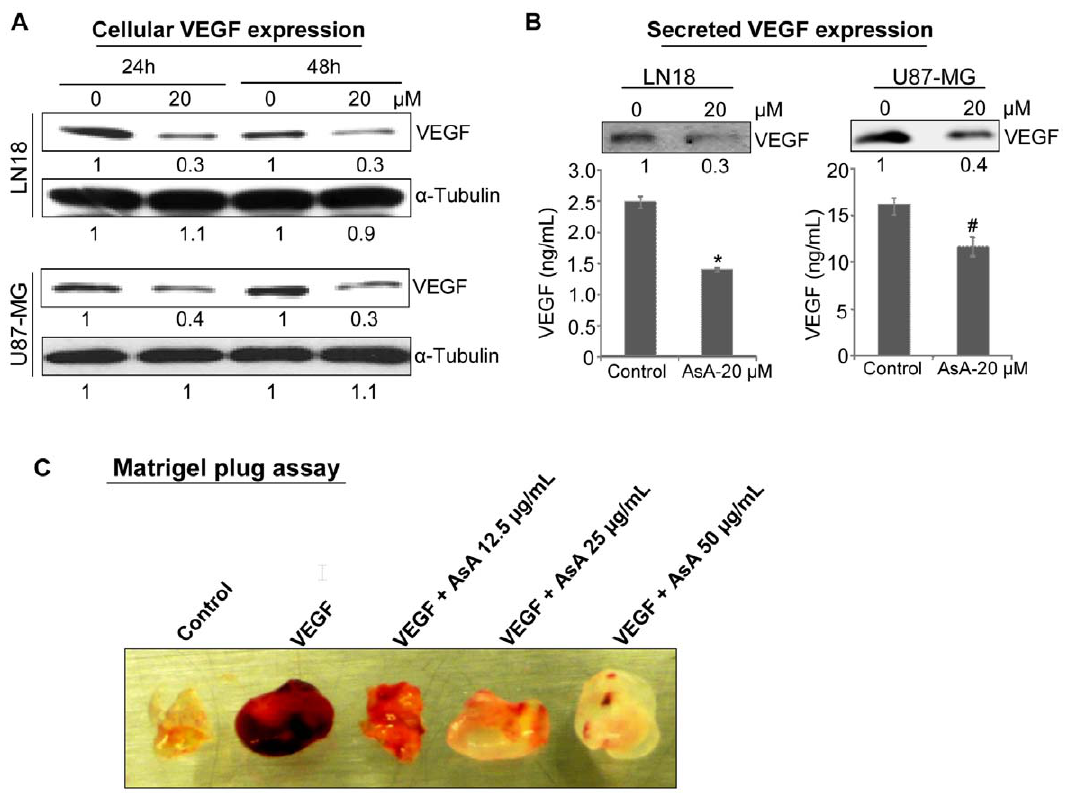
Figure 7. AsA reduces VEGF level (both cellular and secreted) in glioma cells and strongly inhibits VEGF-stimulated angiogenesis in vivo. A. LN18 and U87-MG cells were treated with DMSO or AsA (20 m M) for 24 and 48 h. After each treatment time, cell lysates were prepared and analyzed for VEGF by Western blotting as described in ‘Materials and Methods’. Membranes were stripped and reprobed with anti- a -tubulin antibody to confirm equal protein loading. Densitometric values presented below the bands are ‘fold change’ compared to respective control after normalization with loading control. B. In LN18 and U87-MG cells, media was collected 24 h after AsA treatment (20 m M) and analyzed for secreted VEGF level by Western blotting and ELISA as detailed in ‘Materials and Methods’. C. Nude mice were subcutaneously injected with 0.5 mL Matrigel containing 100 ng/mL VEGF, 100 units of heparin and different doses of AsA (12.5, 25 and 50 m g/mL). Matrigel plugs were removed after 5 days and representative pictures are shown. *, p # 0.001; # , p #